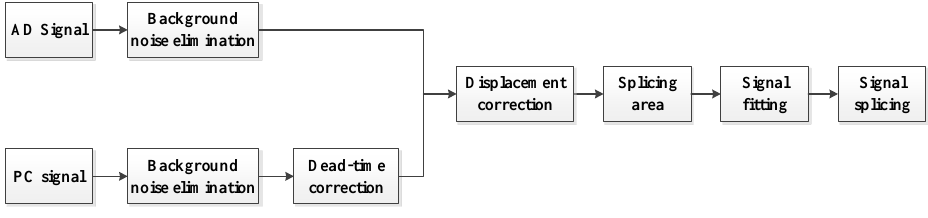
Figure 4. Basic flow chart of signal splicing.